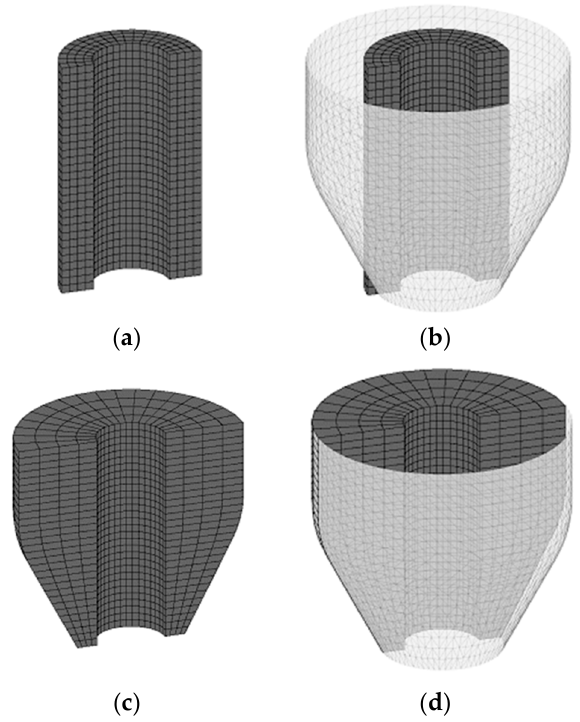
Figure 14. An original shape having a thick walled cylindrical shape.